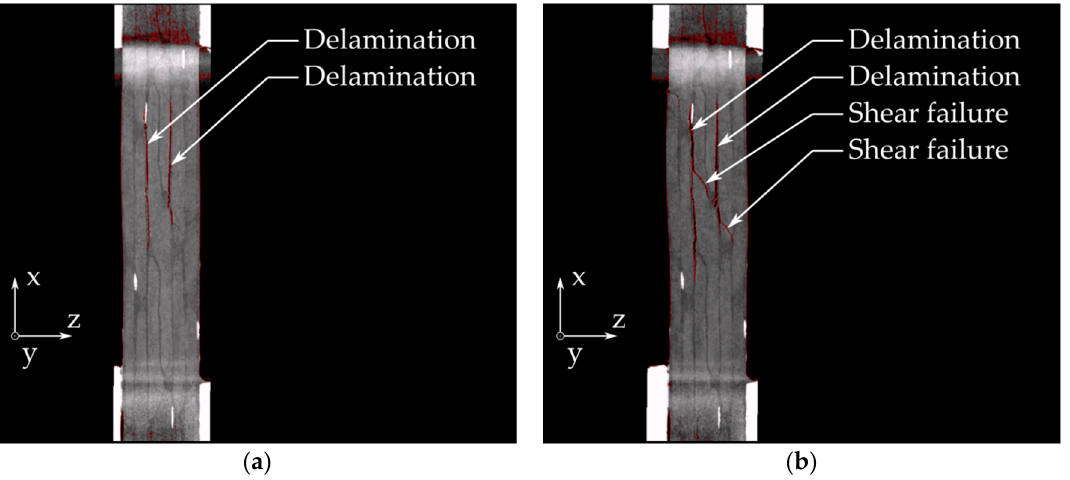
Figure 3. Cross-section visualization of specimen 2 at − 0.5 mm in y-direction: ( a ) point 2, delamina- tion between layers 2–3 and 4–5; ( b ) point 3, shear failure in layers 3–5.